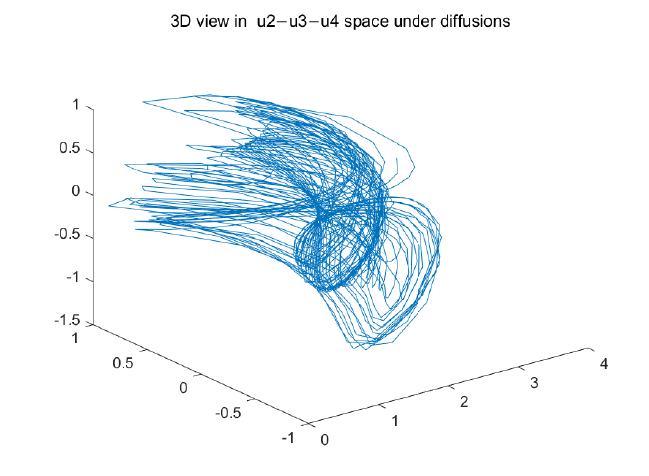
Figure 3. Computer simulations of chaos of financial system under diffusions.